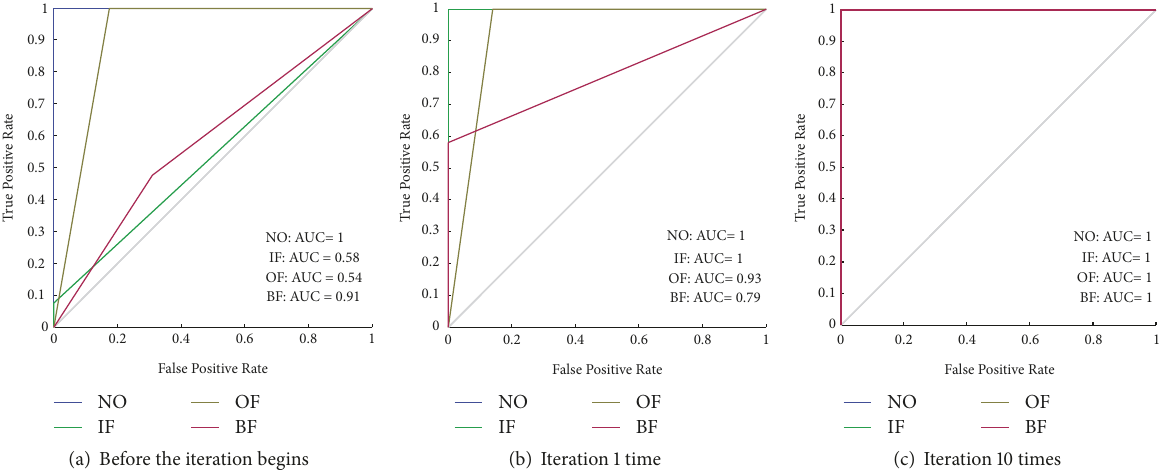
Figure 8: ROC curves of faults detection based on DATF.